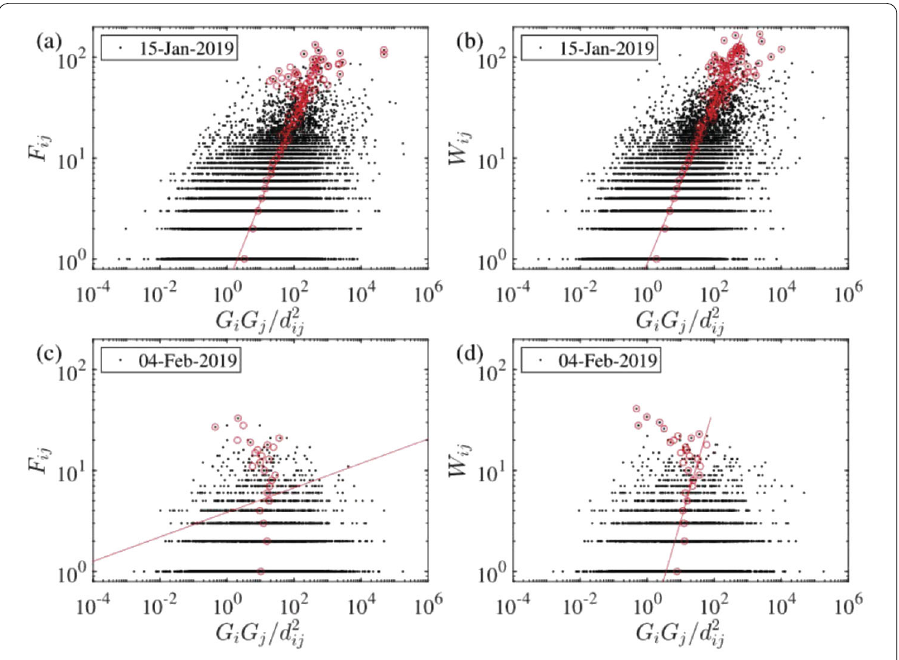
Figure 2 Testing the traditional gravity law with GDP for the daily directed and undirected freight highway transportation networks. ( a ) The directed network on 15 January 2019. ( b ) The directed network on 15 January 2019. ( c ) The directed network on 4 February 2019. ( d ) The undirected network on 4 February 2019